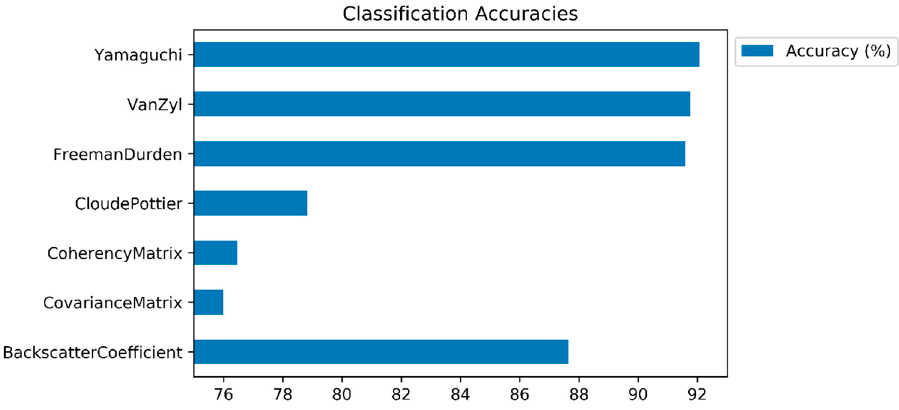
Figure 4. Classification accuracies (overall accuracies).